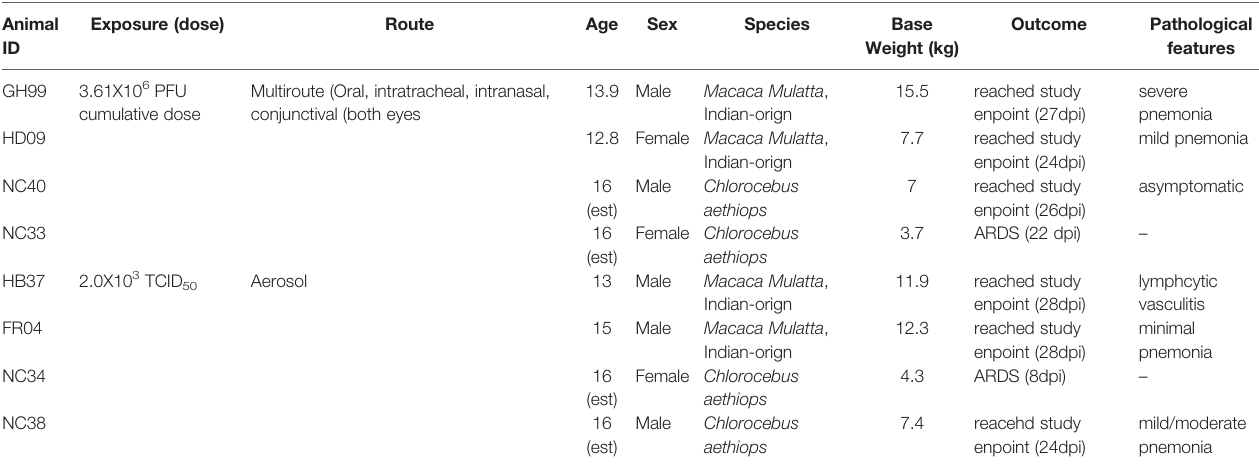
TABLE 1 | SARS-CoV-2 exposure route, demographic, and clinical outcome of NHPs used in the study. Animal Exposure ID